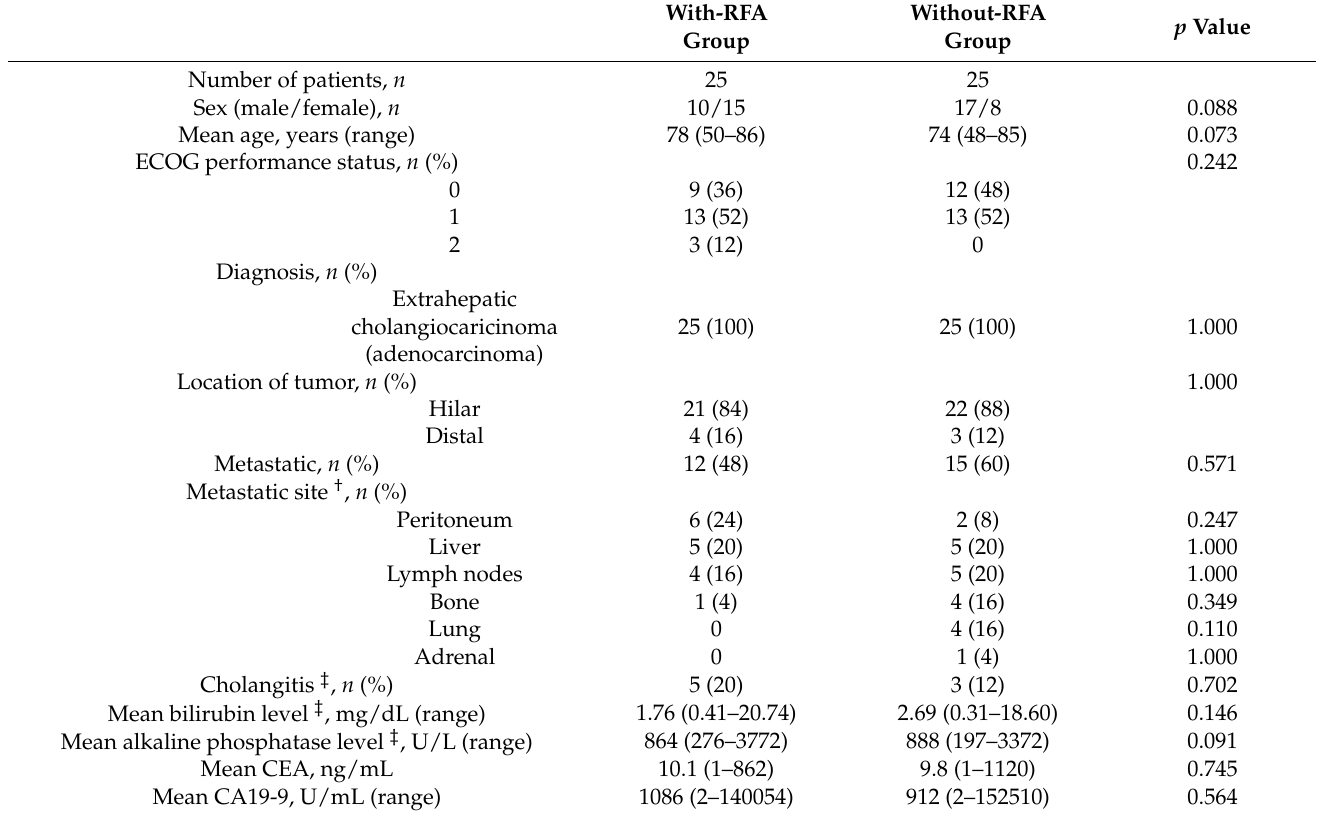
Table 1. Patients’ baseline